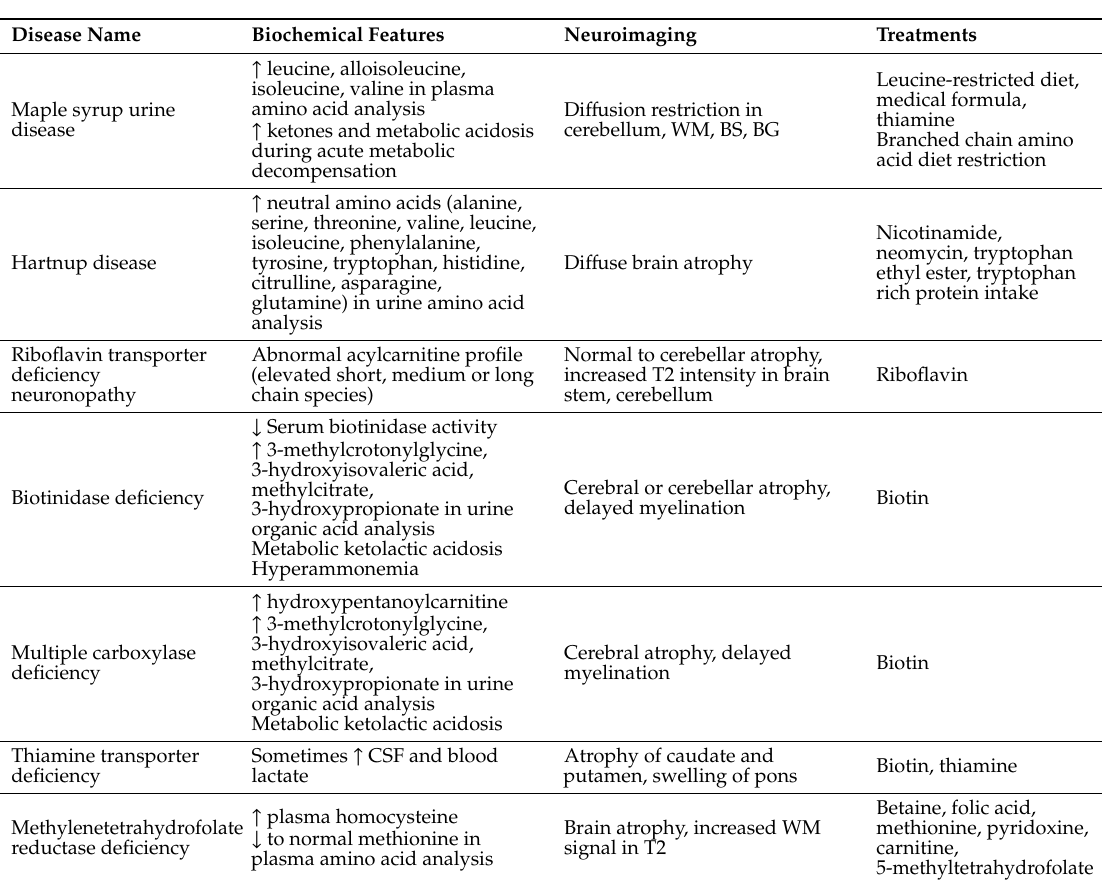
Table 3. Inherited metabolic disorders with specific treatments to amenable disease outcomes and their biochemical and neuroimaging features are summarized in Table